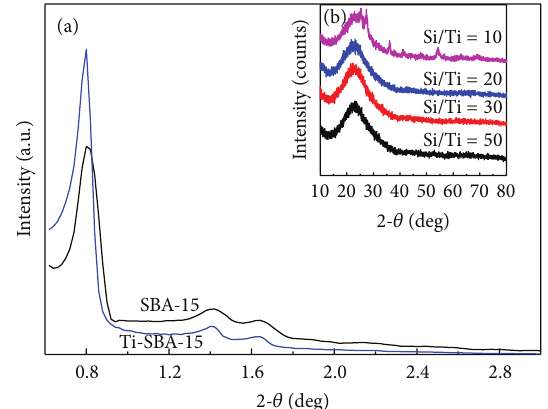
Figure 1: (a) Low-angle XRD patterns of sample SBA-15 and (b) Ti-SBA-15 (Si/Ti = 10) and high-angel XRD patterns of different Ti- containing materials.